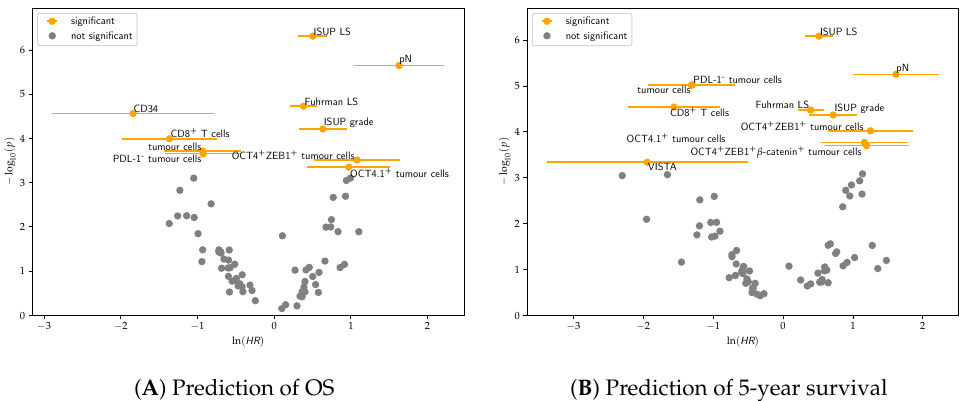
Figure 6. Volcano plots showing significant categorical univariate Cox regression features after Chow–Denning correction and their correlation with OS ( A ) and 5-year survival ( B ). Features with log ( HR ) > 0 are positively correlated with the event, whereas those with log ( HR ) < 0 are negatively